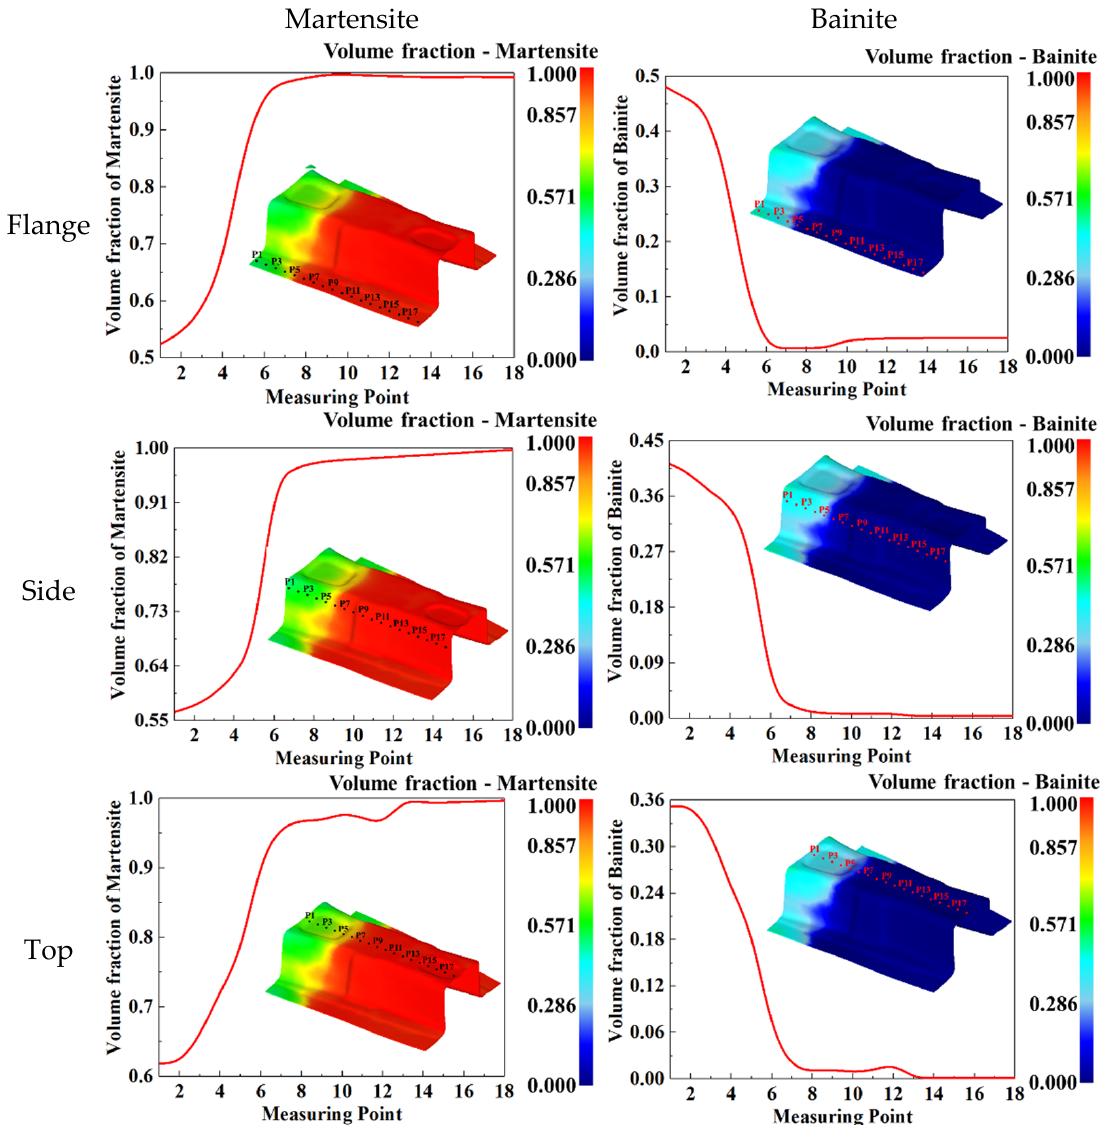
Figure 22. Final microstructures volume fraction of three typical positions: flange, side wall, and top.